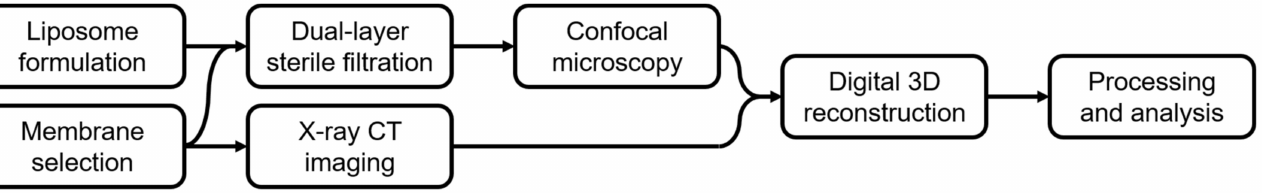
Figure 1. Experimental flow schematic of filtration and imaging